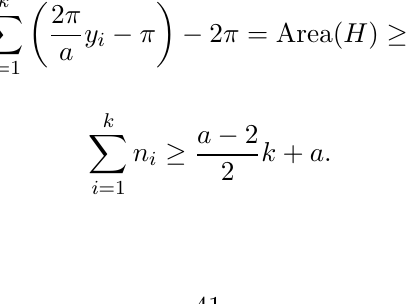
JHEP06(2019)032